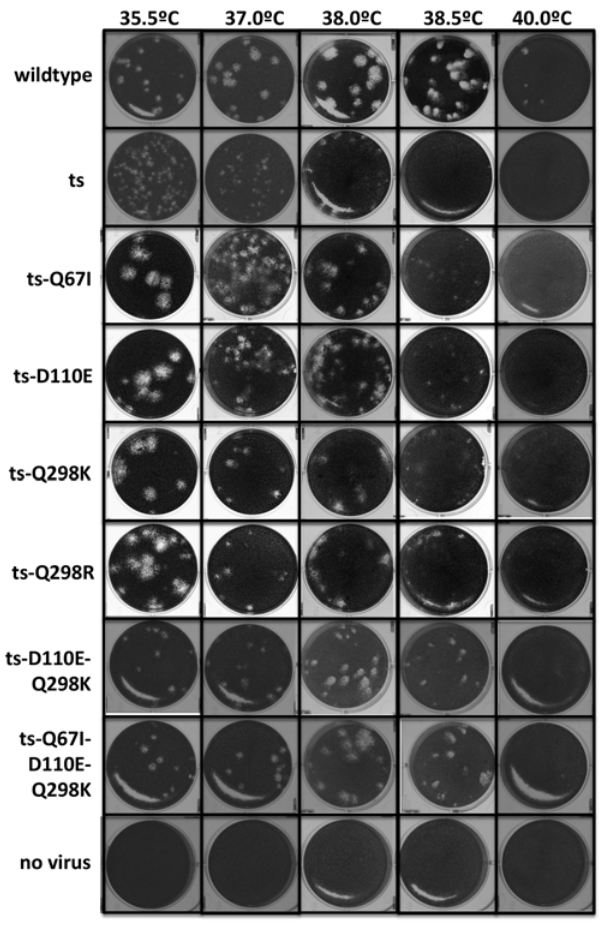
Figure 11. Plaque assays of wildtype, temperature-sensitive (ts), and ts influenza with predicted stabilizing hemagglutinin mutations. All four of the single mutations allow the virus to plaque at higher temperatures than the ts parent. The multiple mutants plaque more effectively at higher temperatures than the single mutants. Mutations are named according to the numbering scheme described in Table 1.